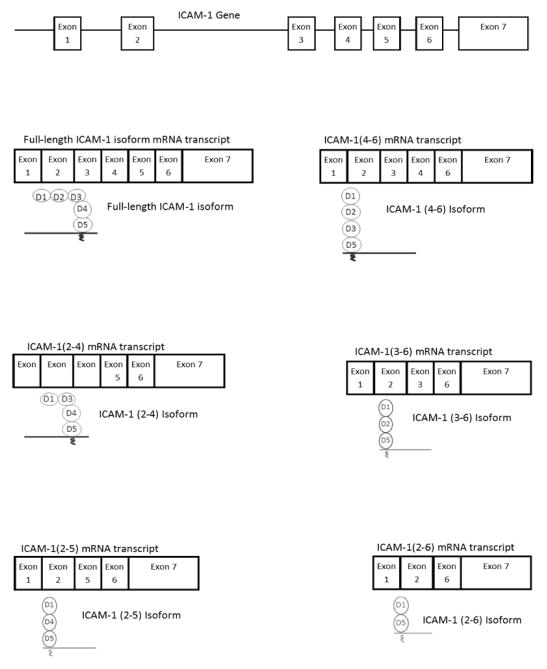
ICAM-1 isoforms